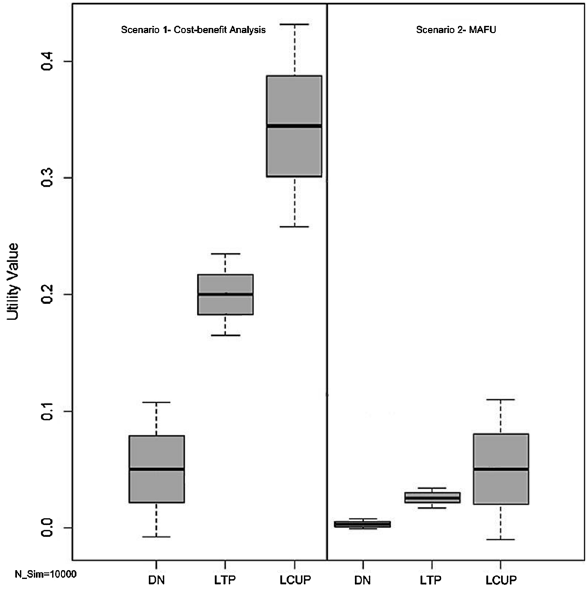
Fig. 5 Sample tradespace of conventional cost–benefit analysis